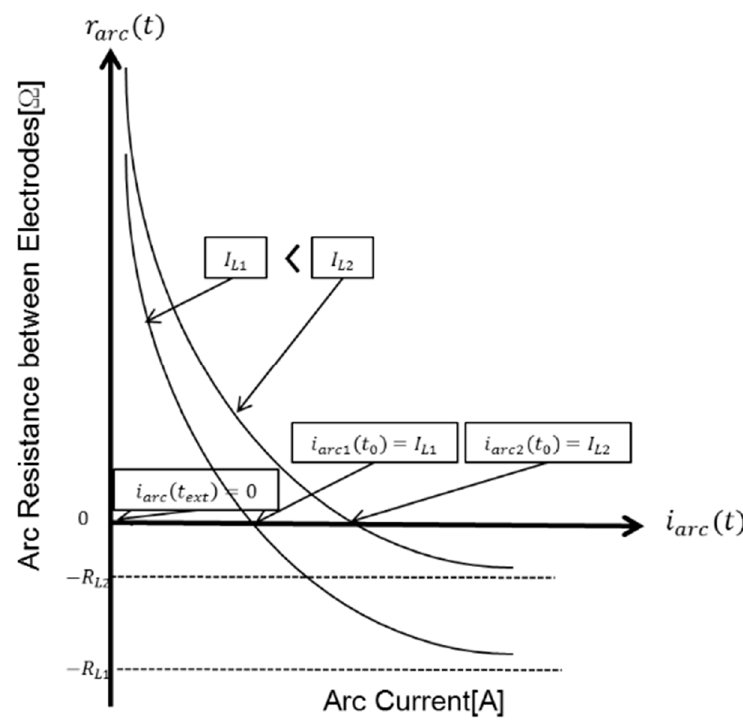
Figure 14. Relation between arc resistance and arc current with the parameter of load current change. Figure 15 is an experimental result graph of r arc and i arc according to the changes in source voltage.